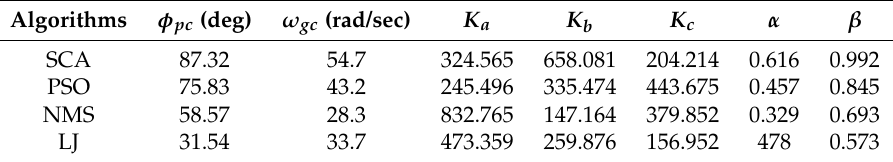
Table 4. Controller parameters and specifications for different